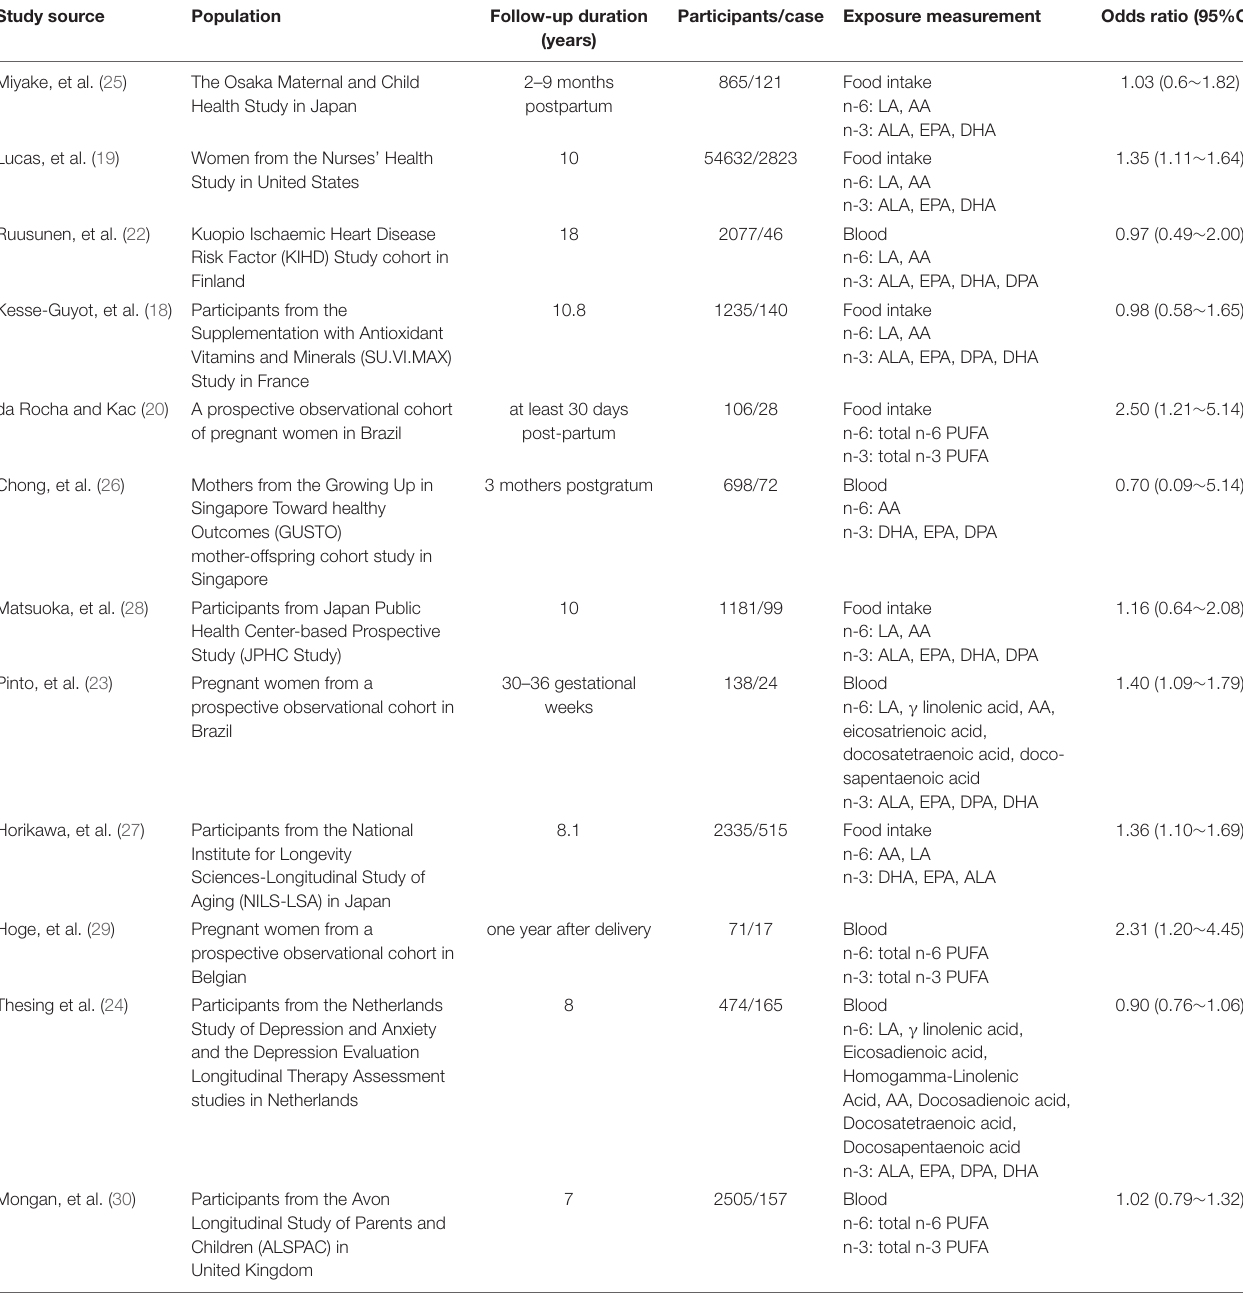
TABLE 1 | Characteristics of the included